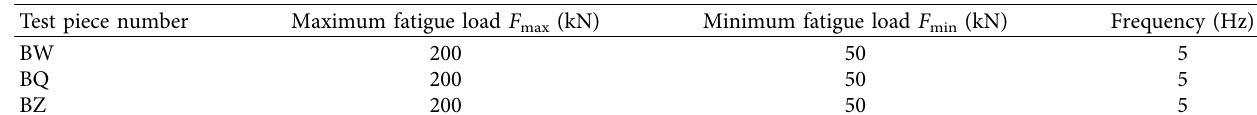
Figure 4: Fatigue loading diagram (units: mm): (a) loading diagram (units: mm) and (b) fatigue loading (units: mm). Table 3: Fatigue test scheme.